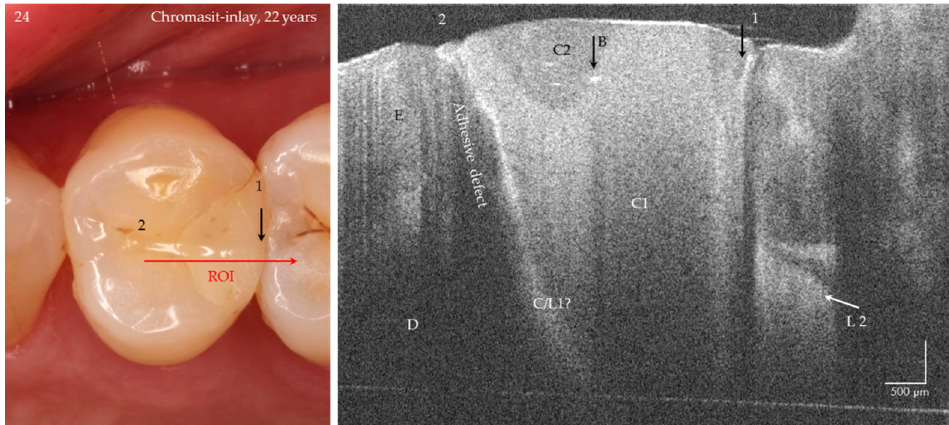
Figure 15. Class I and V composite restorations (C) in teeth 16 and 37 after 24 and 12 years of clinical function, imaged with OCT from the occlusal ( a ) and vestibular view ( b ). ( a ) The surface of the composite restoration (Tetric, adhesive #) shows negative steps at the restoration margins (arrows 1). The marginal discoloration (*) can be explained by the short interfacial marginal gap and not by caries adjacent to the restoration margin (secondary caries) (arrow 2, bright line). Beyond that the bonding interface is still intact after 24 years (no bright signal lines) and the material is homogeneous. ( b ) At the floor of the 12-year-old restoration (Tetric EvoCeram, adhesive #) a short interfacial gap (3) is indicated, the progression of which can be monitored. Compared to tooth 16, the restoration margins are flat, and the material exhibits inhomogeneities. Enamel (E), dentin (D), the enamel-dentin junction (EDJ). The red arrows mark the section planes of the OCT cross-sectional images. The vertical scales are related to the refractive index n = 1.0 (see remark in Figure 4).